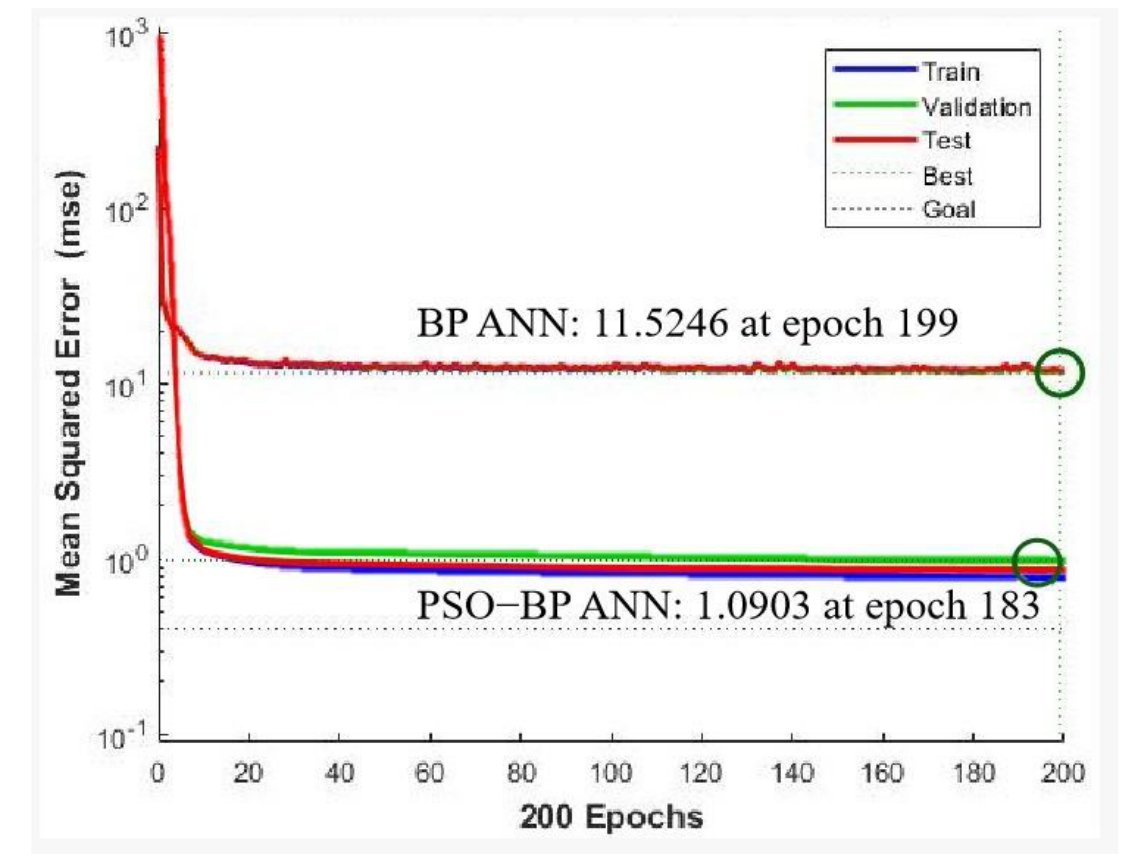
Figure 5. Training performance of the BP ANN and PSO-BP ANN models. Table 5. The weights and bias from the input layer to the hidden